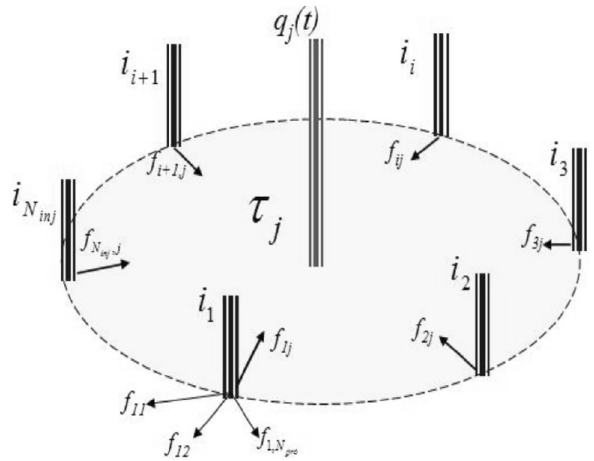
Fig. 1 Schematic representation of CRMP (Sayarpour